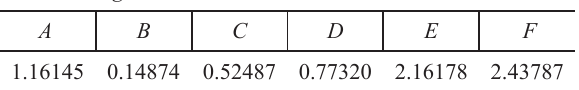
Table 4 – Parameters required for calculating collision inte- gral for molecular diffusion